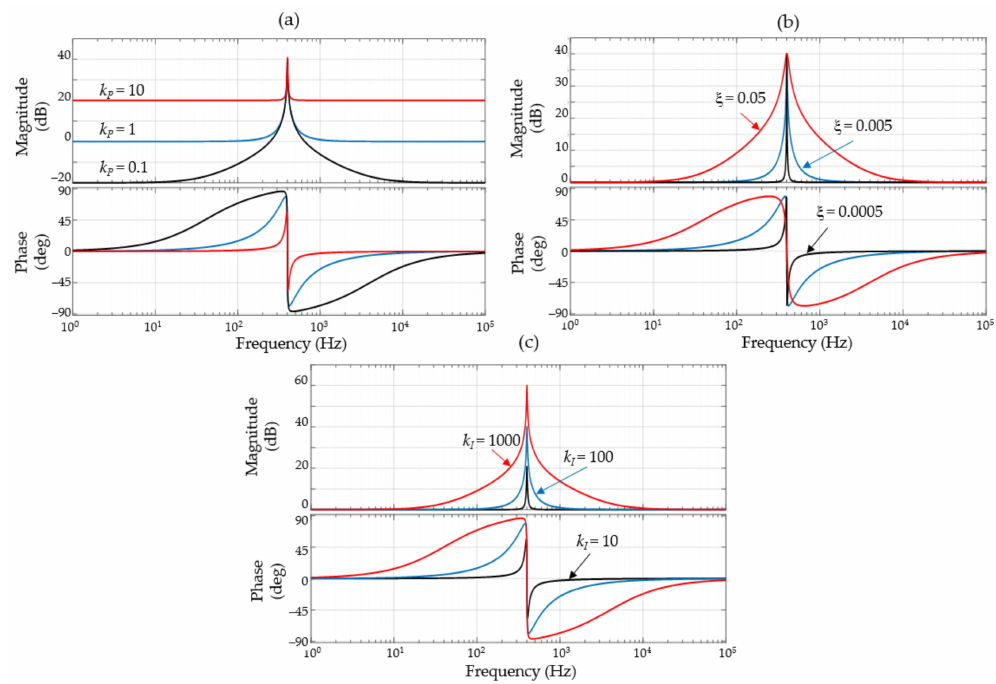
Figure 6. Bode plots of a discrete parallel structure of a digital P+R controller: ( a ) for different gains of the proportional part; ( b ) for different damping factors; ( c ) for different gains of the resonance